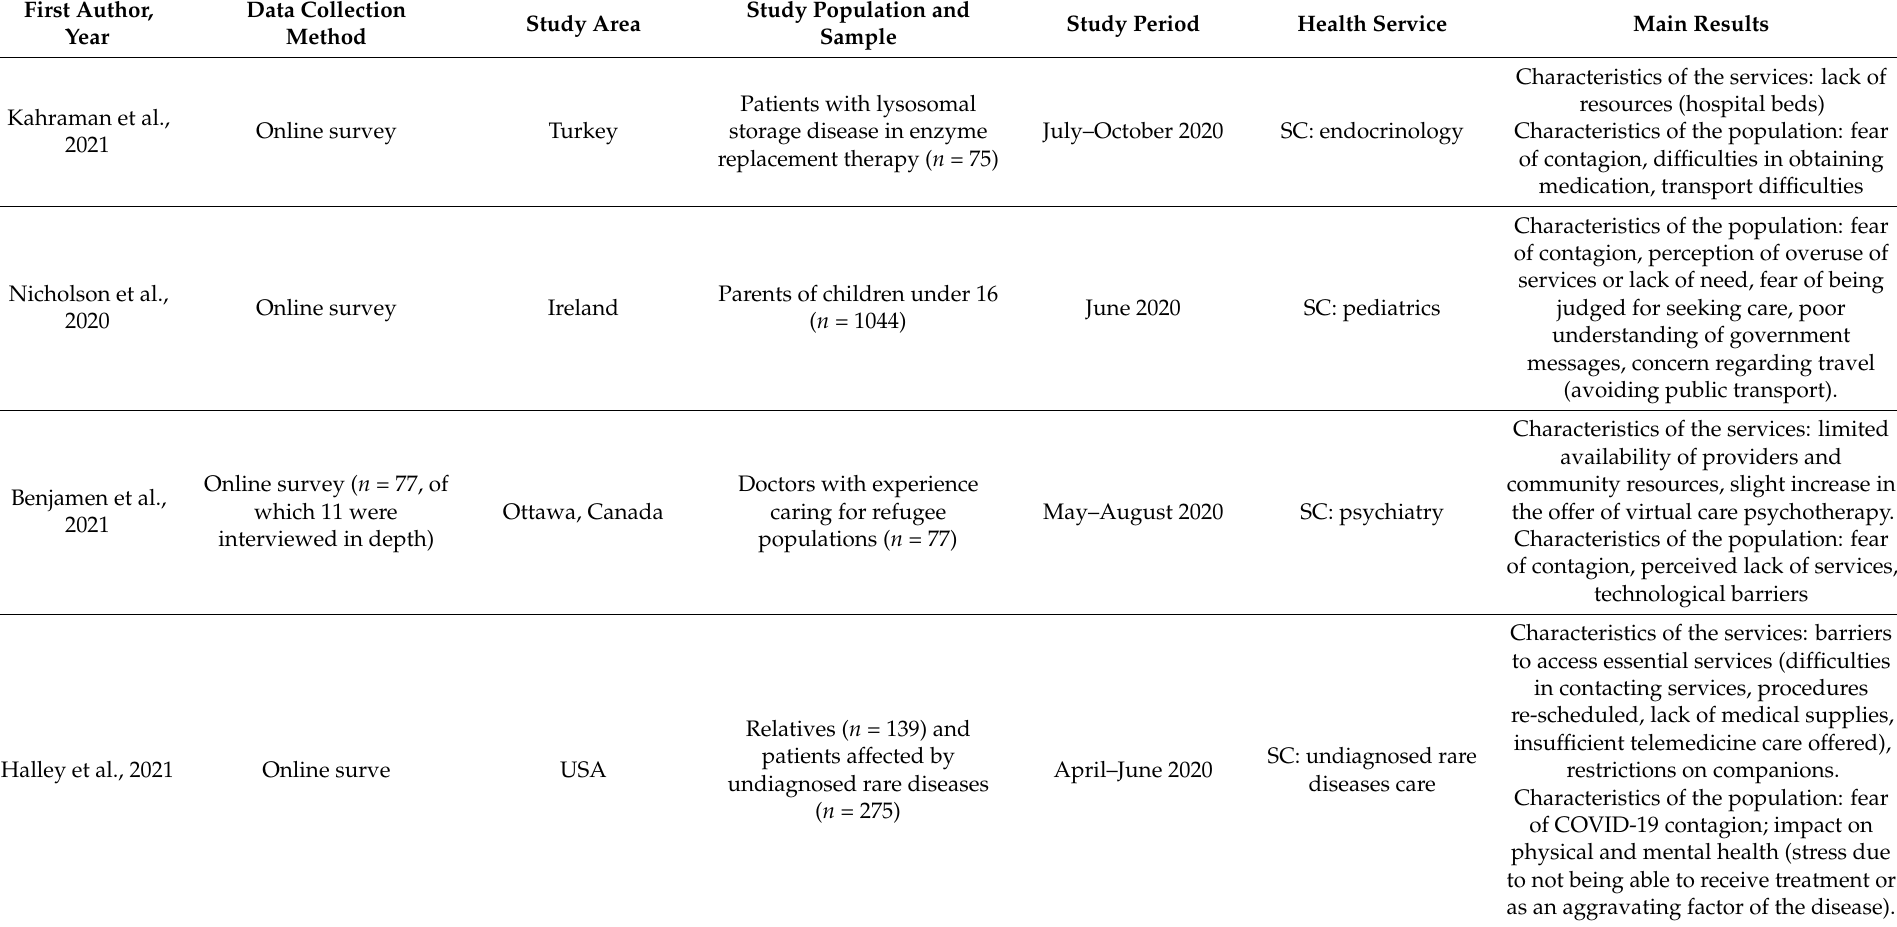
Table 2. Quantitative studies on potential access related to the characteristics of the services and the population during the COVID-19 pandemic in